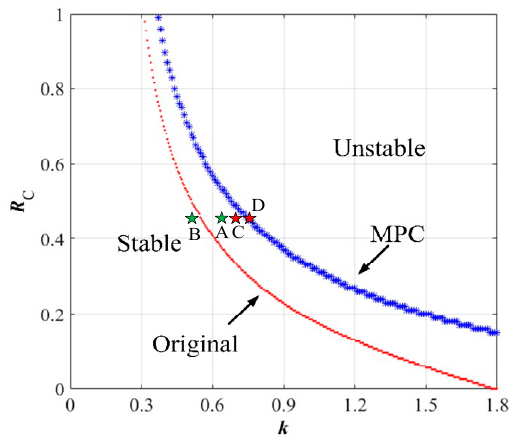
Figure 10. The parameter space under the different control schemes